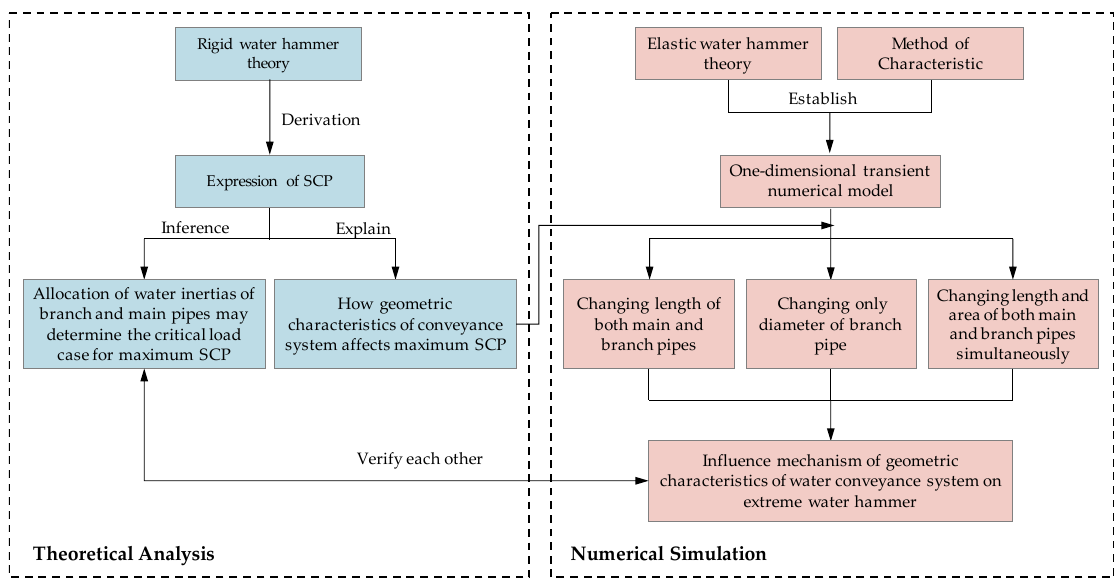
Figure 6. Flowchart of the technical route.